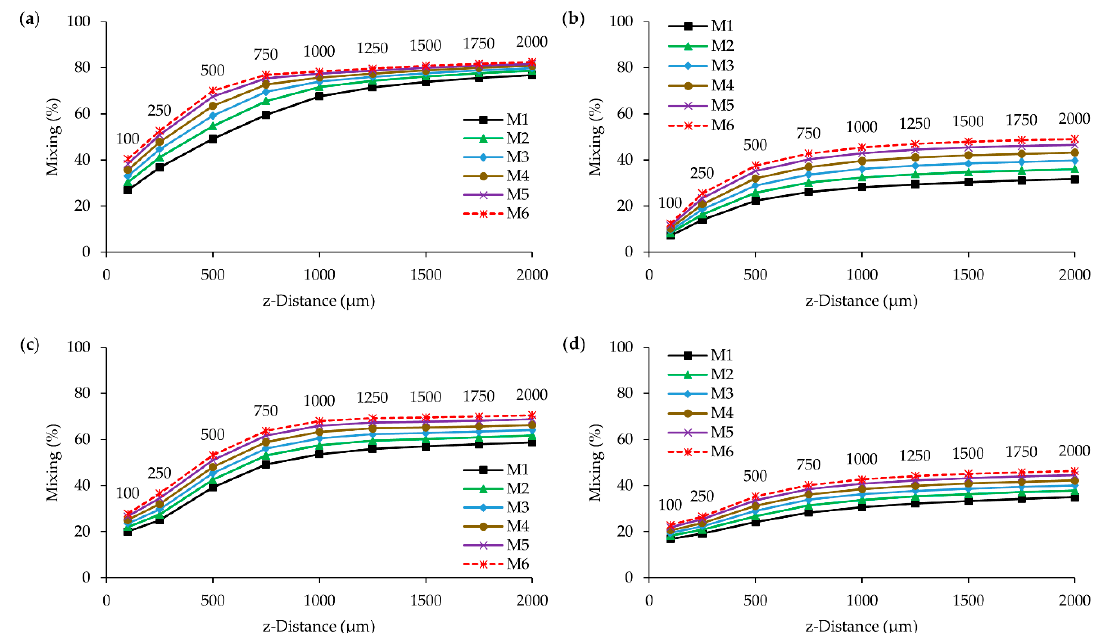
Figure 8. Mixing index (MI) values of different cross ‐ sections along the mixing channel: ( a ) and ( c ) four ‐ inlet and two ‐ inlet designs at Re = 240 respectively; ( b ) and ( d ) four ‐ inlet and two ‐ inlet designs at Re = 120 respectively. Numbers above trendlines show x ‐ axis values in plots.